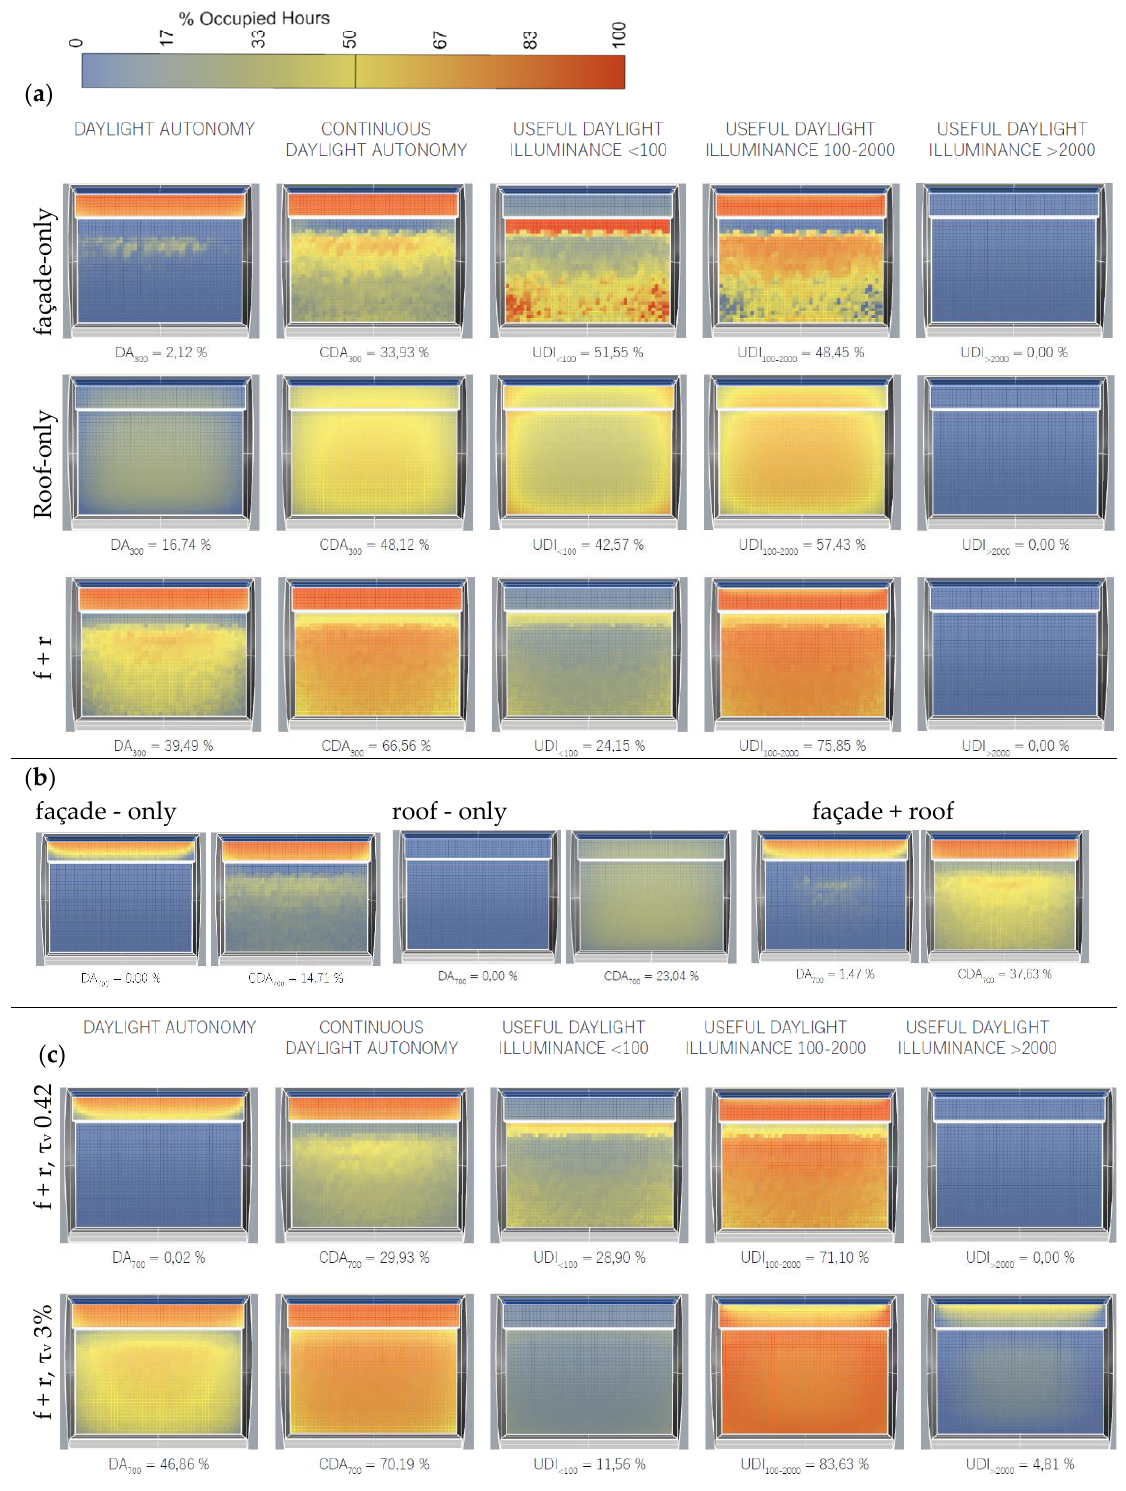
Figure 5. Spatial distribution of annual daylight indicators for scenarios with target illuminance: ( a ) 300 lx, Nos. 1 – 7; ( b ) 700 lx, Nos. 8 – 14; and ( c ) varied transmittance τ v , Nos. 15 and 16. Scenarios Nos. 17 and 18 can be found in Figure A2.